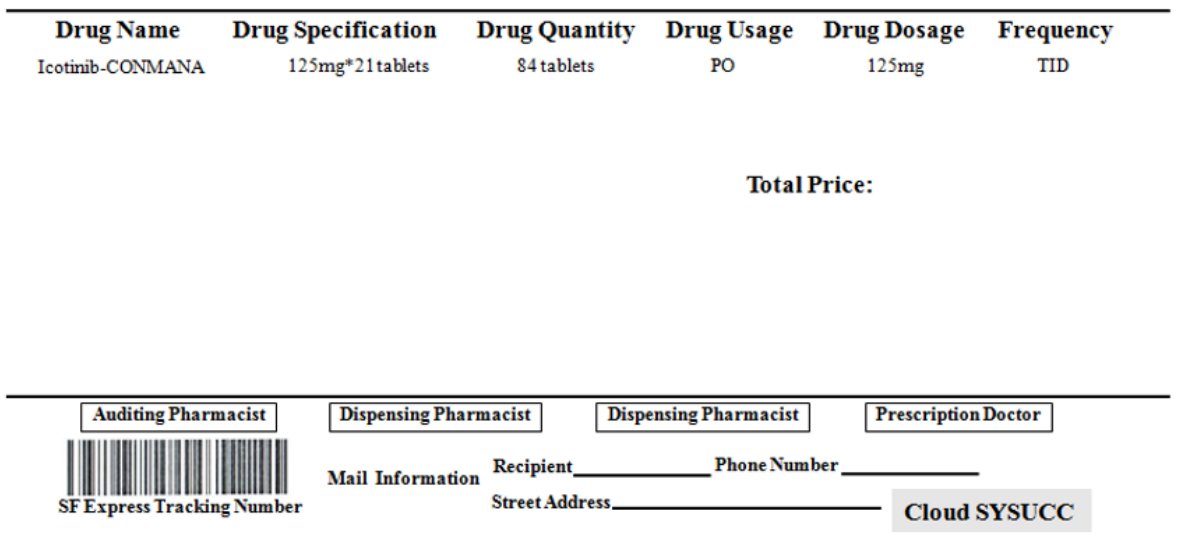
Standard Administration